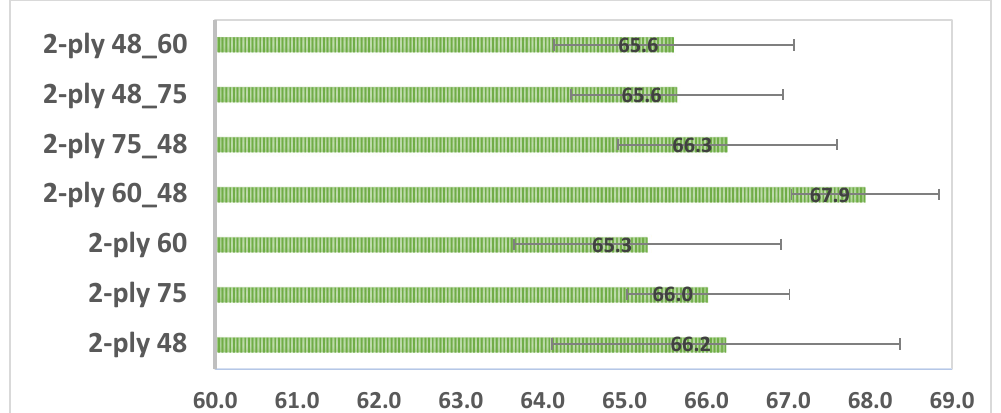
Figure 16. Results obtained for handfeel (HF) with the rubber hardness to the combined 2-ply deco and micro embossed samples.